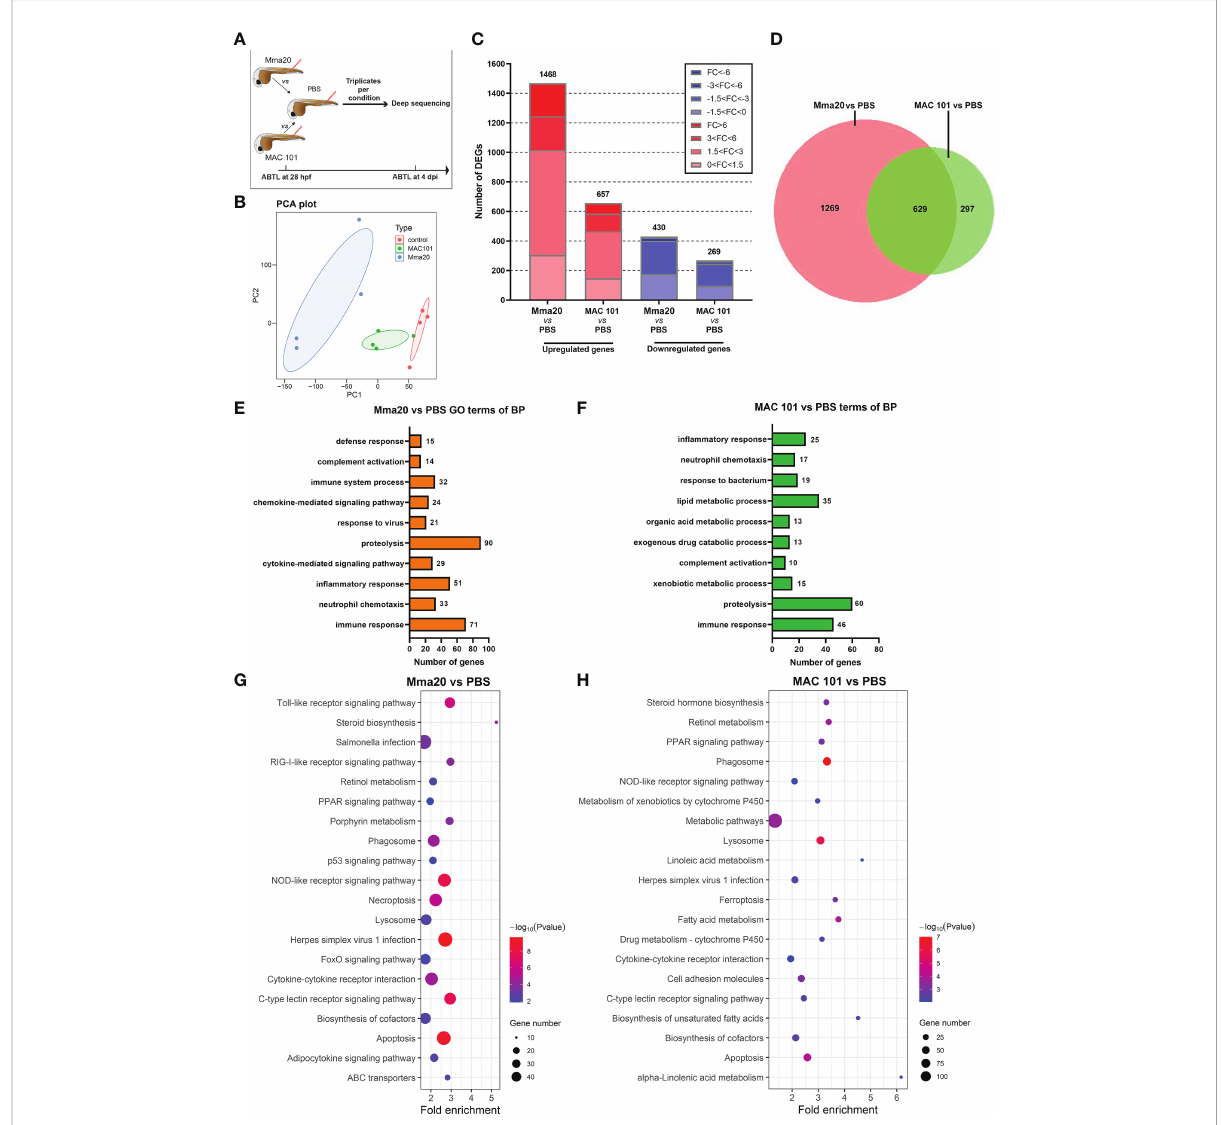
FIGURE 5 Global transcriptome analysis of M. marinum Mma20 vs PBS and M. avium MAC 101 vs PBS groups. (A) Experimental scheme to collect samples for RNA deep sequencing. AB/TL zebra fi sh embryos were injected with ~250 CFU M. marinum Mma20 strain or ~4500 CFU M. avium MAC 101 strain at 28 hpf. The embryos in the control group were injected with sterile PBS with 2% PVP. The samples for RNAseq are taken from four independent sample sets with the injected larvae at 4 dpi. (B) Principal component analysis. The RNAseq samples clustered based on their groups, as showed by the solid ellipses grouping samples. (C) Overview of the distribution of DEGs fold change in zebra fi sh larvae infected with Mma20 or MAC 101. DEGs were assessed by FDR p-value < 0.05. Upregulated gene sets are shown in red and downregulated gene sets are shown in blue. The intensity of the color represents the fold change level. (D) Venn diagram shows the common and speci fi c DEGs number between the 250 CFU Mma20- infected group and 4500 CFU MAC 101- infected group compared to the control. The Venn diagrams were made by the website: https://www.biovenn.nl/. (E) The top 10 gene ontology (GO) terms of biological process with lowest P value in the Mma20- infected larvae compared to the control group. (F) The top 10 GO terms of biological process with lowest P value in the MAC101- infected larvae compared to the control group. (G) Top 20 signi fi cantly enriched KEGG pathways in the Mma20- infected larvae compared to the control group. (H) Top 20 signi fi cantly enriched KEGG pathways in the MAC 101- infected larvae compared to the control group. The GO analysis and KEGG pathway enrichment analysis were performed by using DAVID. In (G, H) , the size of circle represents the enriched gene numbers, bigger circle indicates more enriched genes were found in this pathway. The color of circle represents -log10 (P